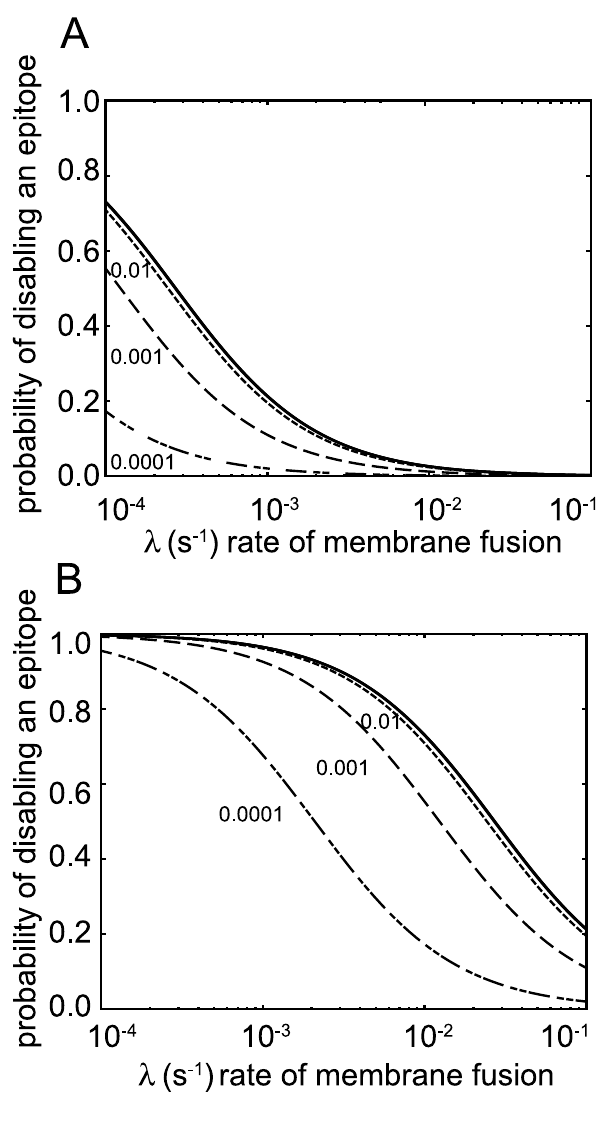
Figure 2. The probability of disabling an epitope, p b , versus the rate at which membrane fusion occurs, l , for different values of the disabling rate, d T . The probability was calculated from Eqs. (7) and (8) for two different 4E10 Fab concentrations, 5 | 10 { 9 M in A and 5 | 10 { 7 M in B, using the parameter values given in Table 2. The values of d T in s { 1 used to generate the various curves are given in the figures. The curves for d T § 0 : 1 s { 1 are indistinguishable. The top curves (solid black) in A and B each correspond to three curves generated for d T ~ 0 : 1 s { 1 , 1 : 0 s { 1 and ? s { 1 .